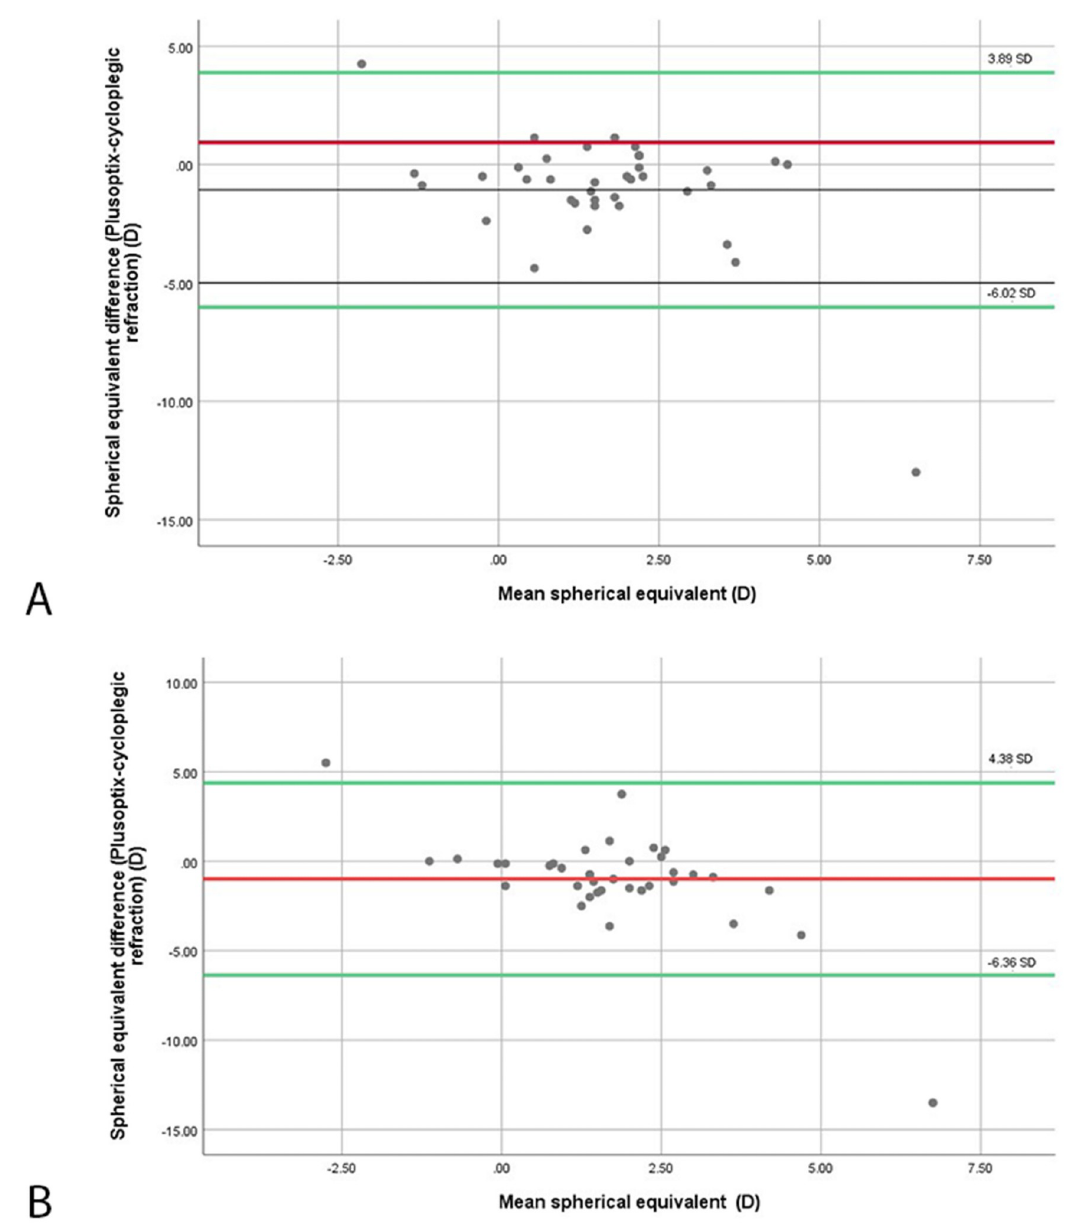
Fig 1. Bland-Altman plot of spherical equivalent values of the right eye (OD) (A) and the left eye (OS) (B) in diopters. The difference between the mean spherical equivalent as measured by PlusoptiX and mean spherical equivalent as measured by cycloplegic retinoscopy are plotted on the y-axis, and the mean spherical equivalent value obtained by the two measurements on the x-axis. Dashed lines represent the upper and lower 95% limits of agreement.